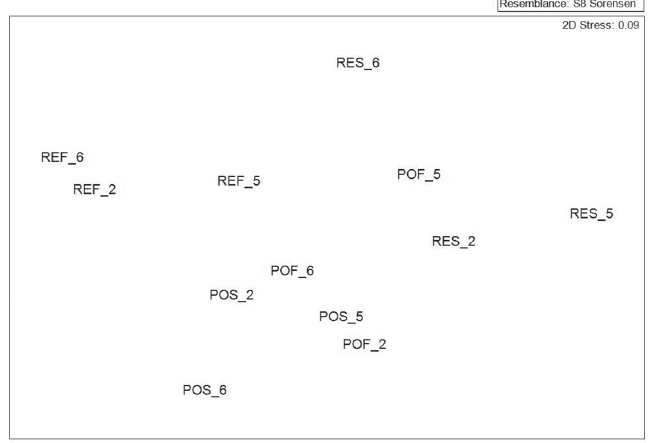
Figure 3 - nMDS plot of PCR-amplified SSU rRNA fragments of Bacteria pooling all triplicate samples. S – Superficial water; F – Deep water; 2 – April sampling; 5 – October sampling; 6 – January sampling.